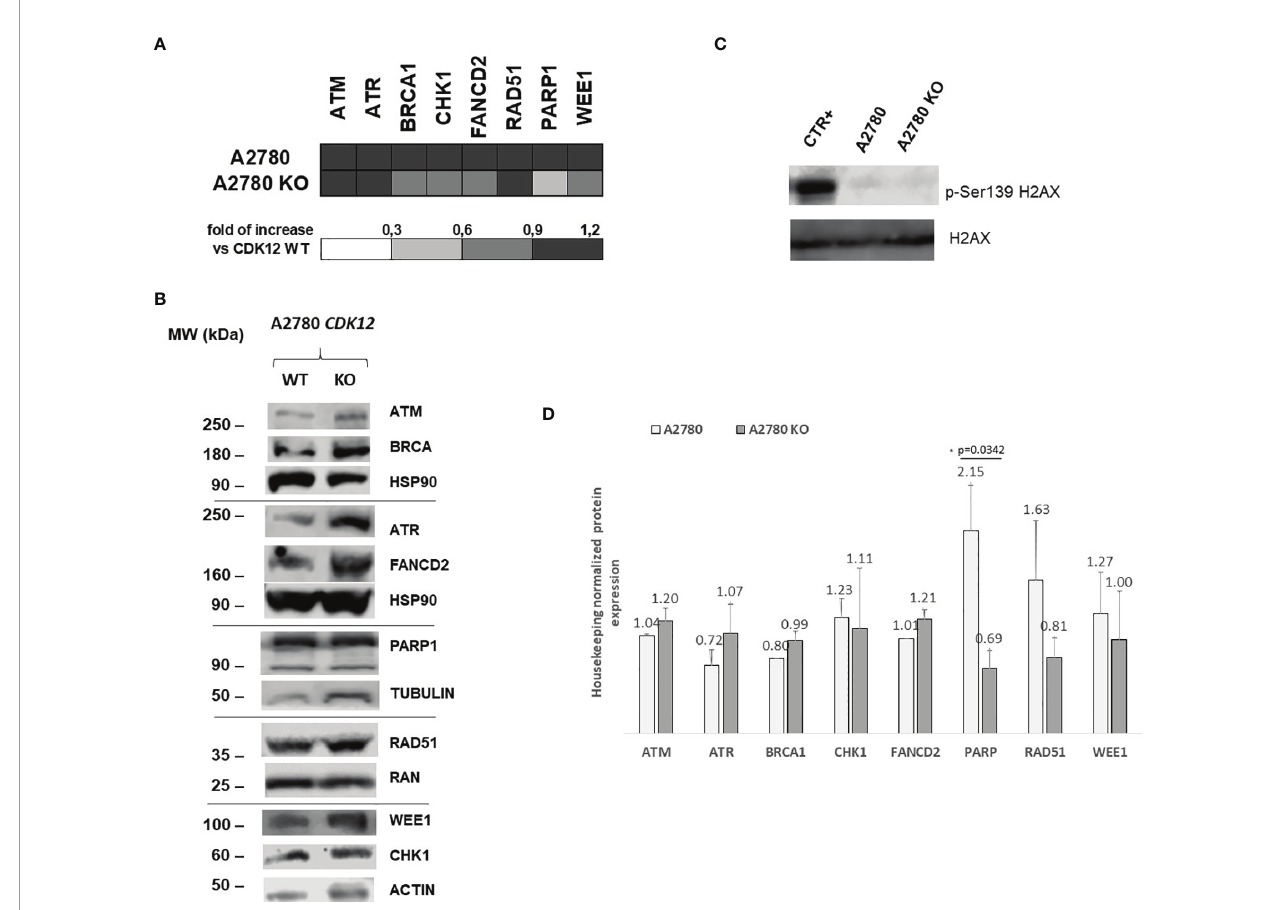
FIGURE 4 | DNA repair gene expression in A2780 and A2780 CDK12 KO cells. (A) mRNA levels of ATM, ATR, BRCA1, CHK1, FANCD2, RAD51, PARP1, WEE1 in A2780 and A2780 CDK12 KO cell lines obtained by RT-PCR. Values are the mean+SD of three independent experiments, done in triplicates and are expressed as the fold of change over the CDK12 WT cell line. (B) Western blot analysis showing ATM, HSP90, ATR, FANCD2, BRCA1, PARP1, RAD51, b tubulin, CHK1, WEE1, ACTIN, p-Ser139 H2AX, H2AX protein levels in A2780 and A2780 CDK12 KO cells lines. All the protein blots for western analysis have been cropped before antibody hybridization to be able to detect in the same fi lter different proteins. (C) Western blot analysis showing p-Ser139 H2AX, H2AX protein levels in A2780 and A2780 CDK12 KO cells. All the protein blots for western analysis have been cropped before antibody hybridization to be able to detect in the same fi lter different proteins. (D) Quanti fi cation of the western blot data by densitometric analyses. Values are normalized by actin and are the mean+SD of three replicates.*p =